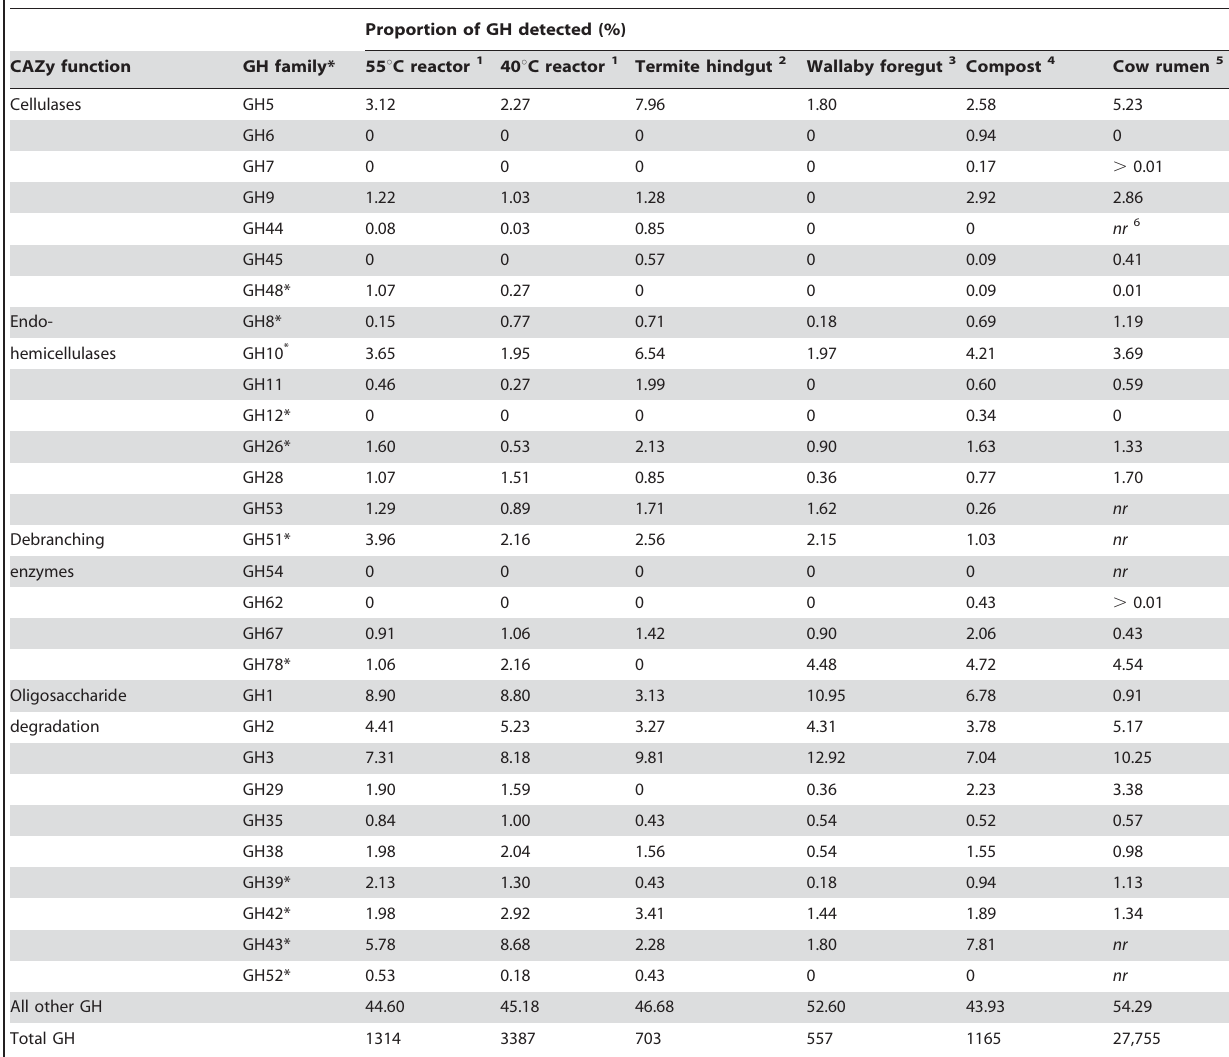
Table 3. Distribution of selected CAZy families biomass-degrading